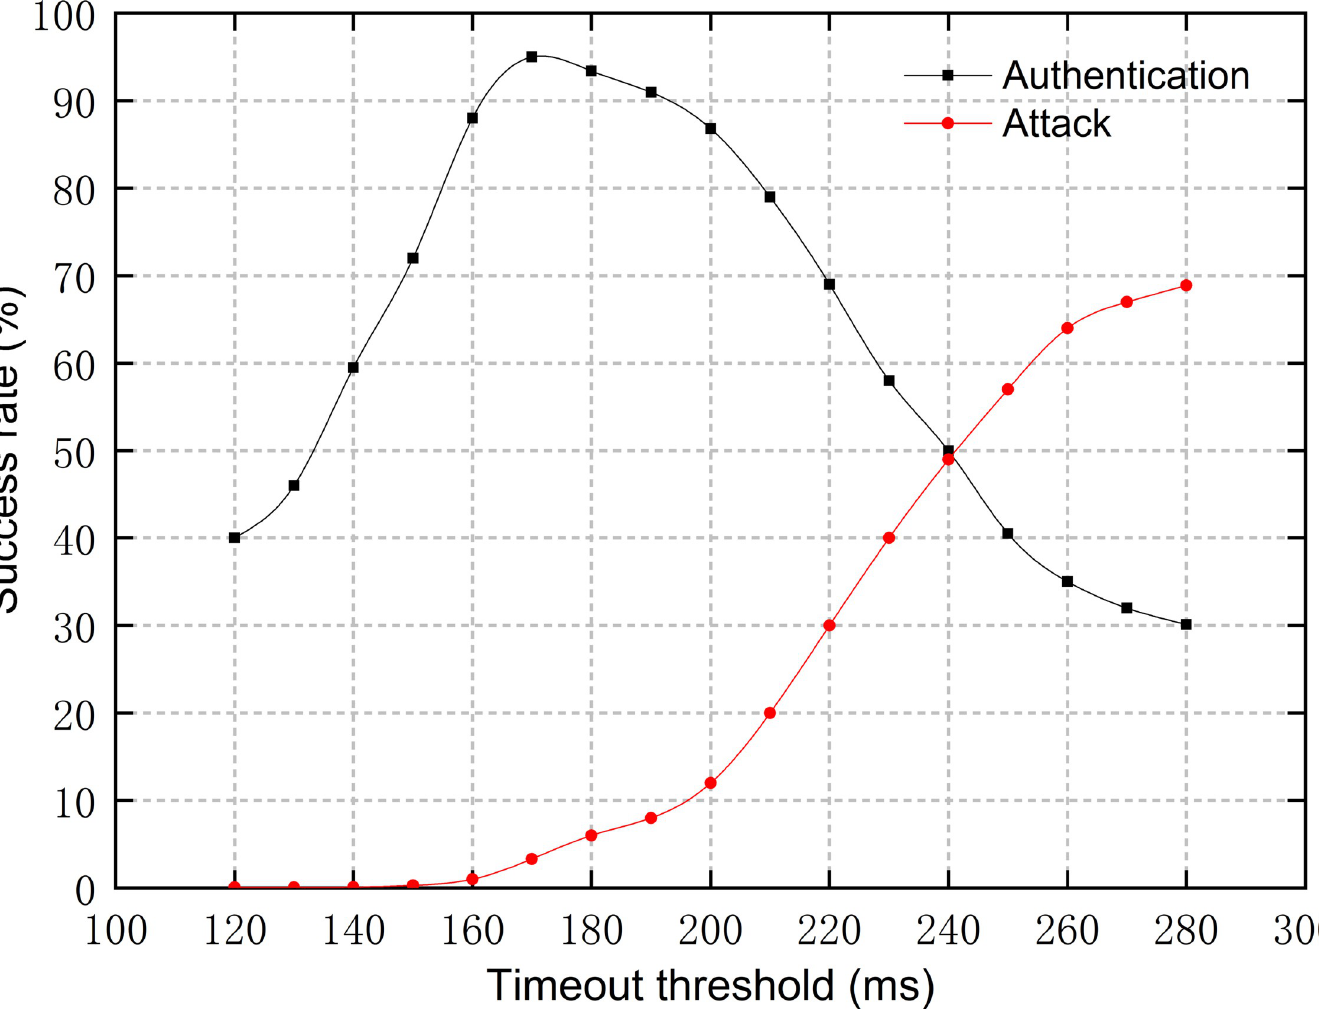
Fig 12. Authentication success rate and attack success rate at different timeout thresholds under scenario 1.